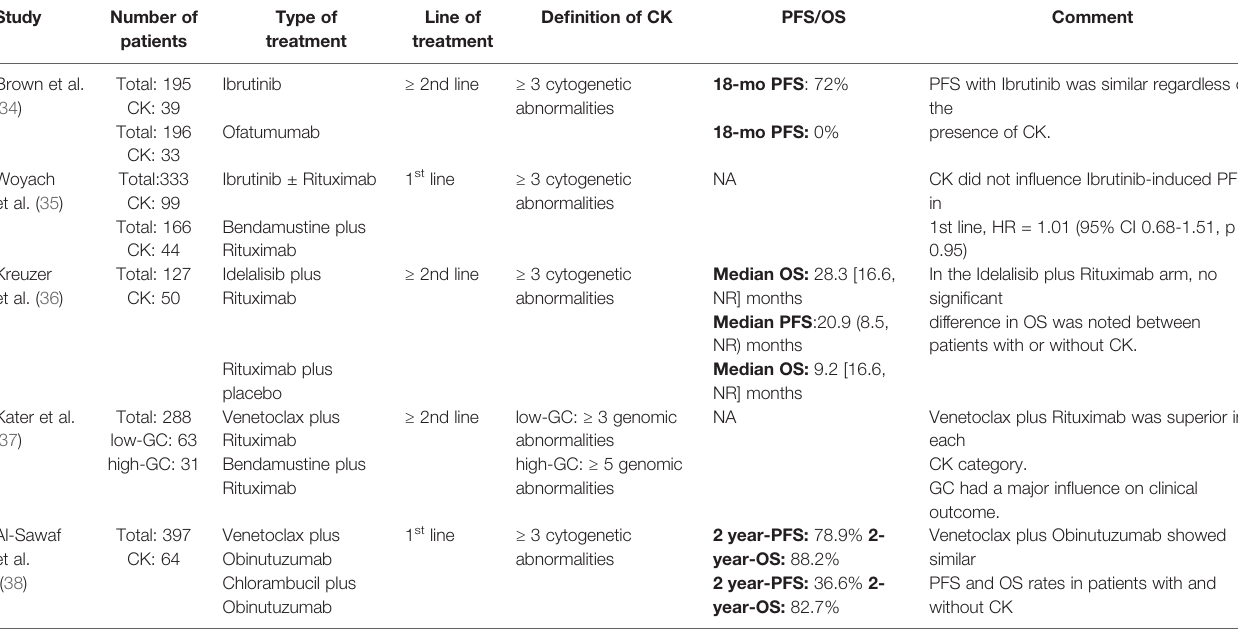
TABLE 1 | Randomized control trials that assessed the impact of complex karyotype in chronic lymphocytic leukemia.